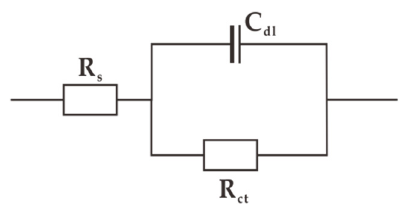
Figure 7. The equivalent circuit used for EIS data fitting. Table 3. Electrochemical parameters of EIS data for different colored specimens.